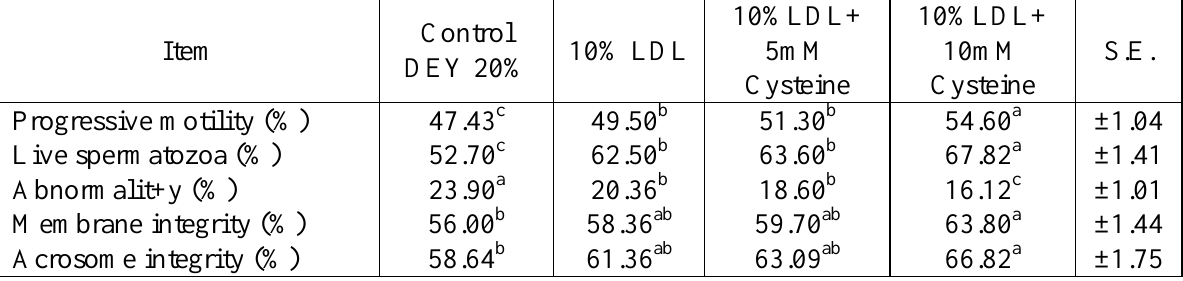
Table 6: Effects of LDL and Cysteine based extender on Post-thawing parameters of Holstein bull spermatozoa (Mean ± S.E):